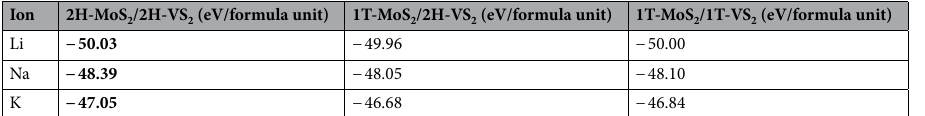
Table 3. Energy of different phases of lithiated 1-MoS 2 /1-VS 2 heterostructure (with alternating layers of MoS 2 and VS 2 ) after Li, Na and K intercalation. The numbers in bold identify the lower energy phases of the TMDs in the presence of various intercalating